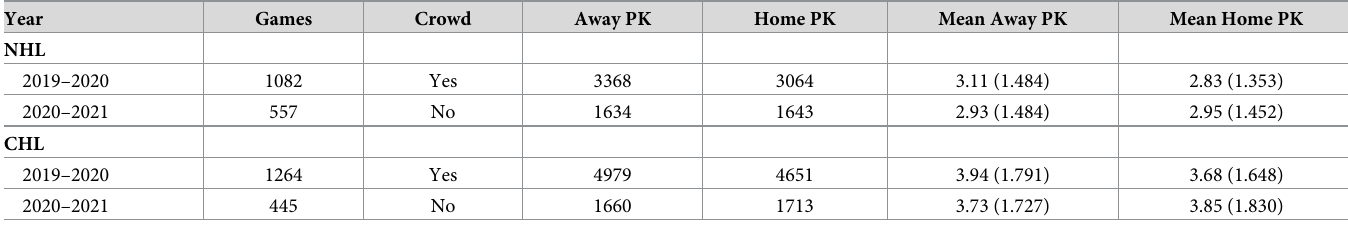
Table 4. Penalty kills per year during the NHL and CHL regular